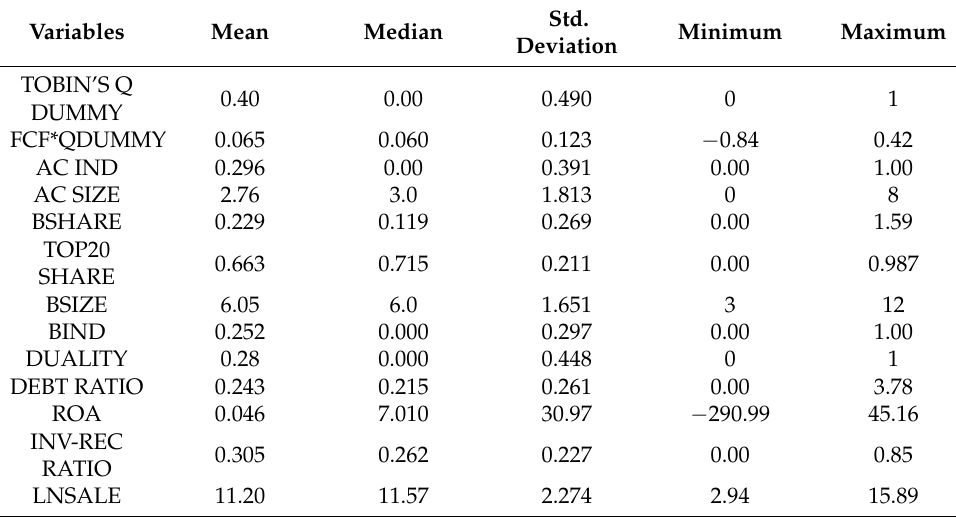
Table 3. Summary